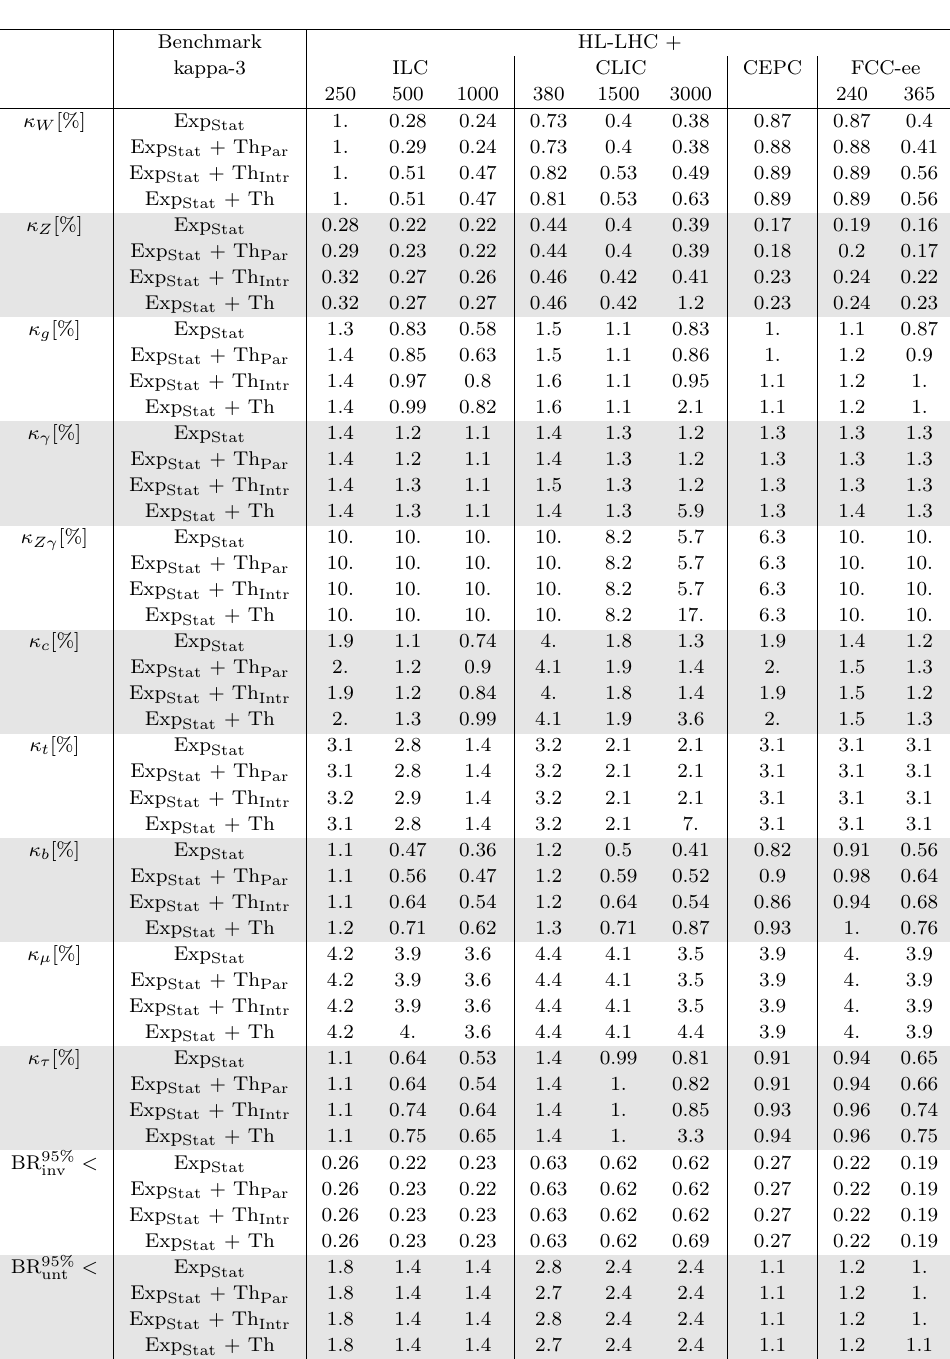
Table 10 . Comparison of the sensitivity at 68% probability to deviations in the di(cid:11)erent Higgs couplings modi(cid:12)ers in the kappa-3 (cid:12)t, under di(cid:11)erent assumptions for the SM theory